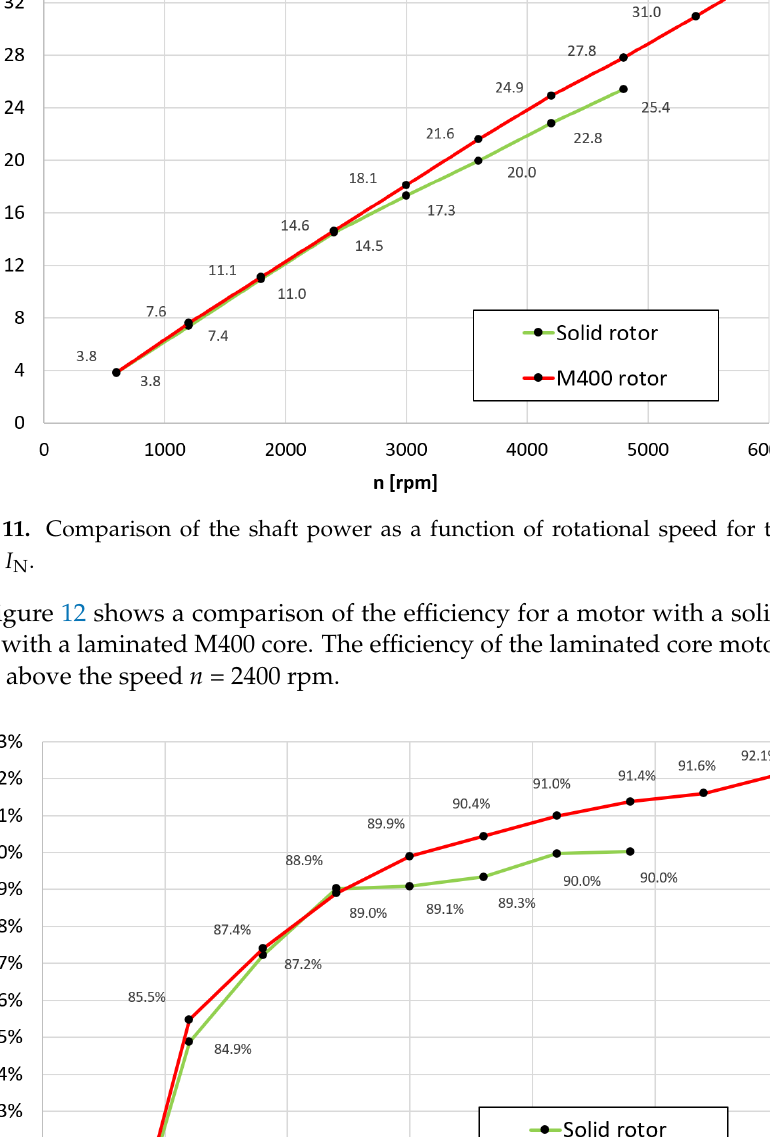
Figure 10. Comparison of the shaft torque as a function of changes in rotational speed for the rated load current I N .